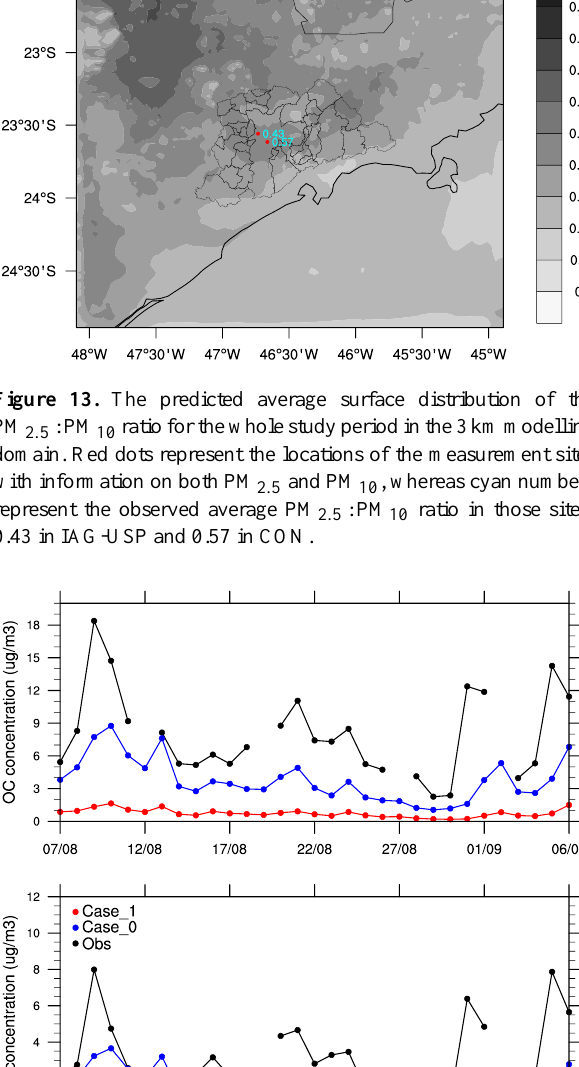
Figure 12. The predicted average surface distribution of PM 10 con- centrations for the whole study period in the 3km modelling do- main. Red dots represent the locations of the measurement sites with information on PM 10 , whereas cyan numbers represent the observed average PM 10 concentration in those sites: 49.5µgm − 3 in IAG-USP and 38.7µgm − 3 in CON.